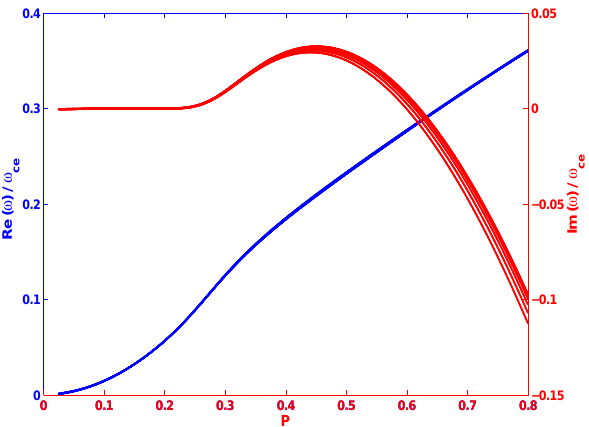
Fig. 8. WHAMP results: Real frequency Re( ω) / ω ce (bule line) and Imaginary frequency, i.e. damping/growth rates, Im( ω) / ω ce (red line) of the whistler anisotropy instability as function of the modu- lus of the wave number P = kρ e and for different wave angles (wave vectors with the respect of the ambient magnetic field) between 0 ◦ and 5 ◦ from top to